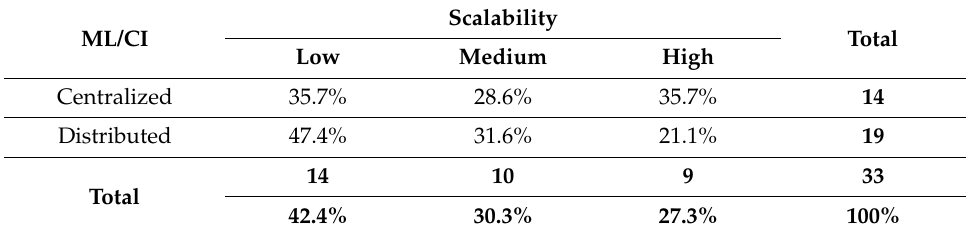
Table 6. Comparison of CI’s approaches according to the nature of the approach.